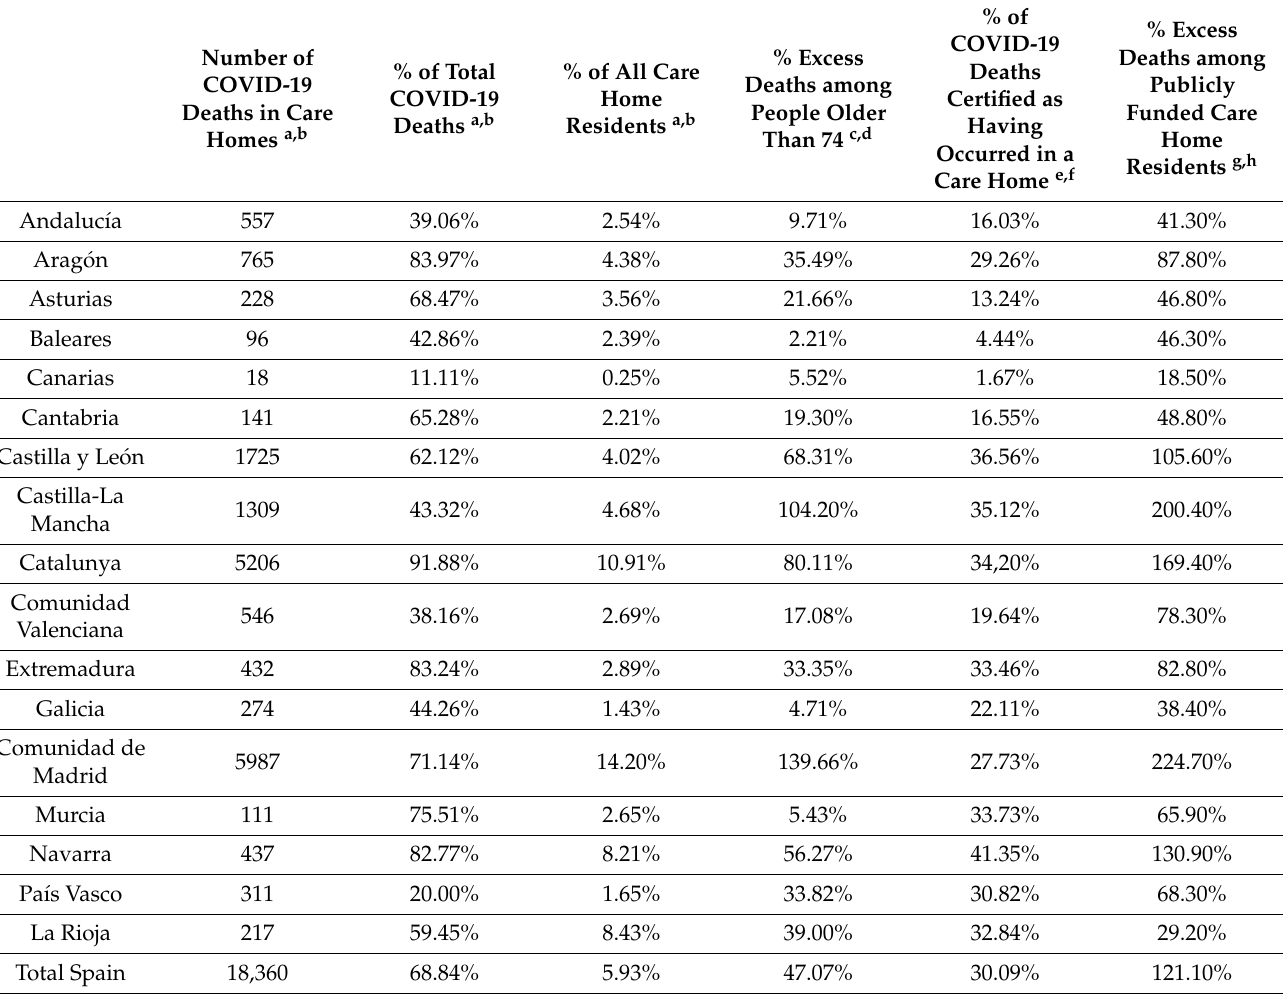
Table 1. Care home COVID-19 mortality indicators in Spain disaggregated by Autonomous